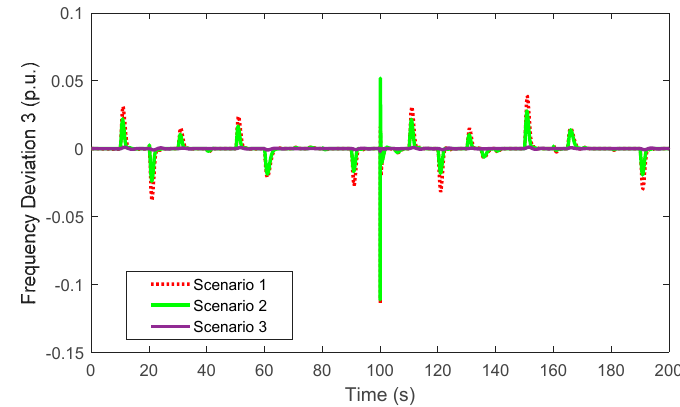
Figure 12. Comparison of the frequency deviations of microgrid 2 in the three scenarios.